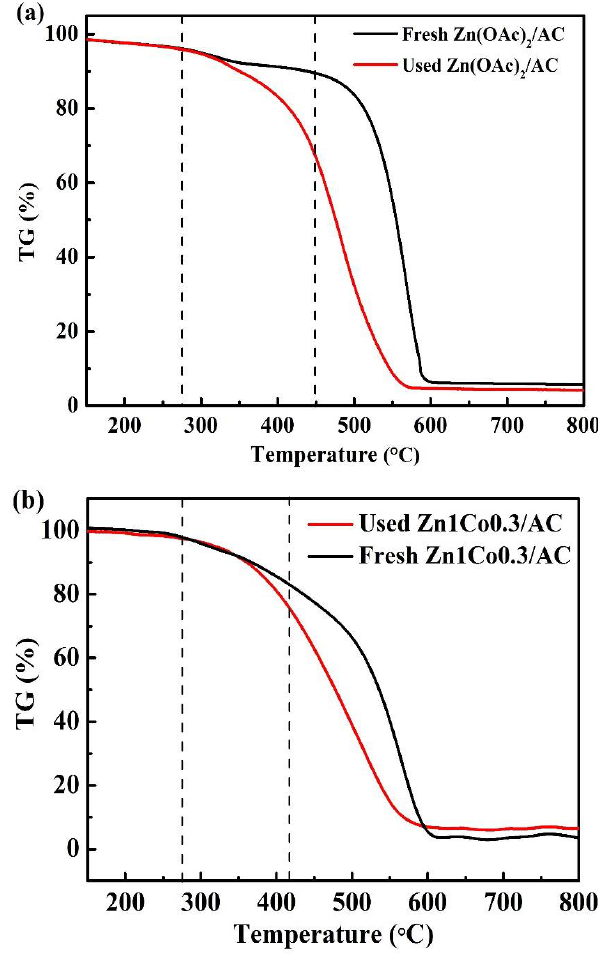
Figure 7. TG curves of fresh and used Zn(OAc) 2 /AC ( a ) and Zn1Co0.3/AC ( b ) catalysts.